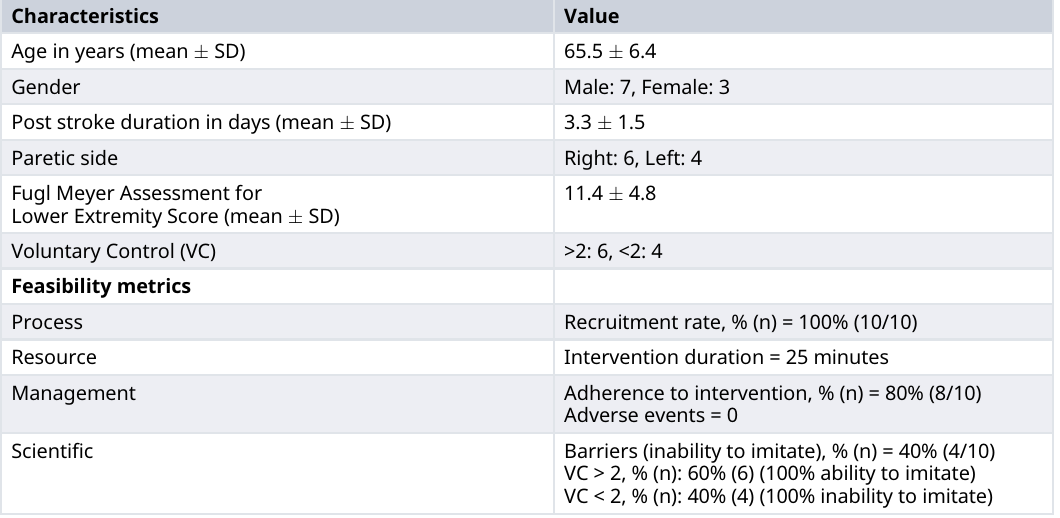
Table 4. Demographic details and feasibility metrics of participants (n = 10).